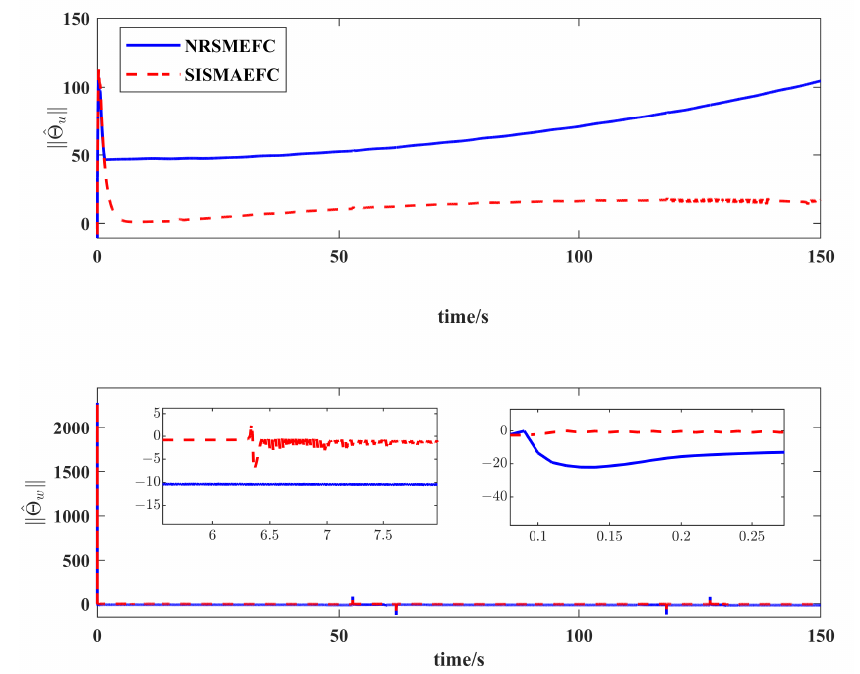
Figure 11. Comparison of compensation values of adaptive